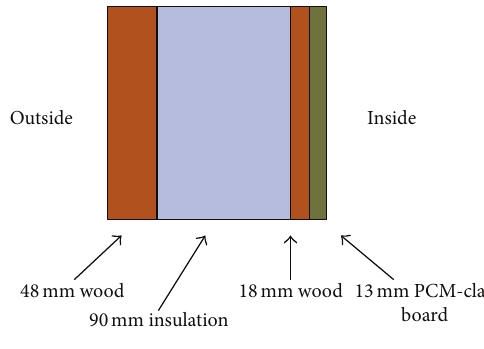
48 mm wood Figure 7: Experimental wall construction.